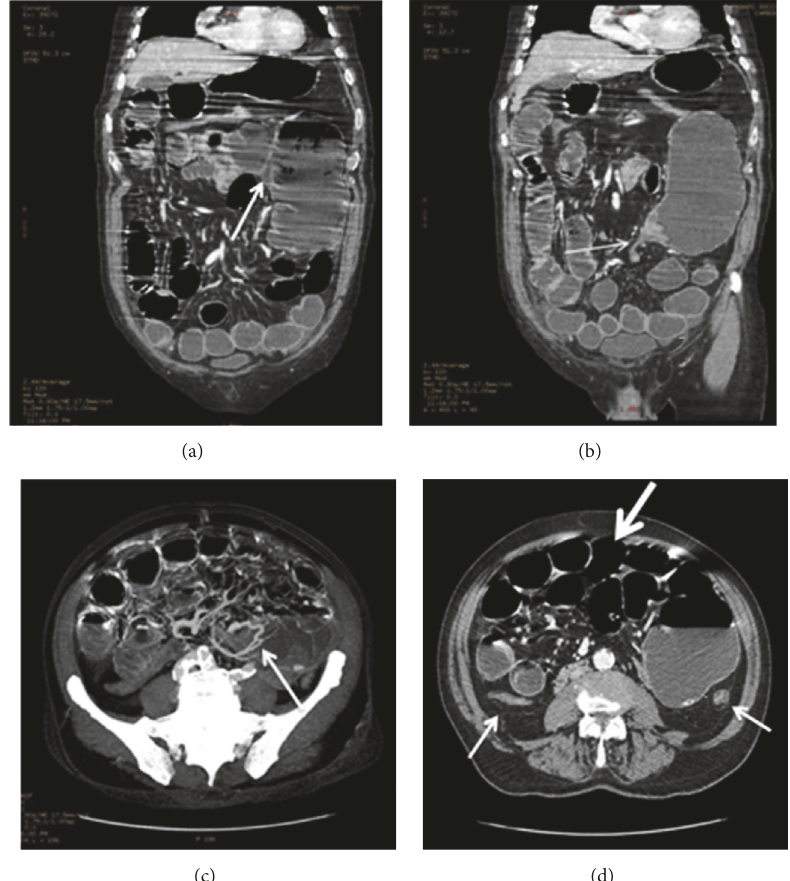
Figure 1: (a) Medially placed ileocecal valve (arrow). (b) Dilated, twisted cecum with tip pointing to left upper quadrant (arrow). (c) “Whirlpool” sign: tightly twisted mesentery and bowel vessels. (d) Dilated small bowel loops with air fluid levels (thick arrow) and distended gas or fluid-filled small bowel (white